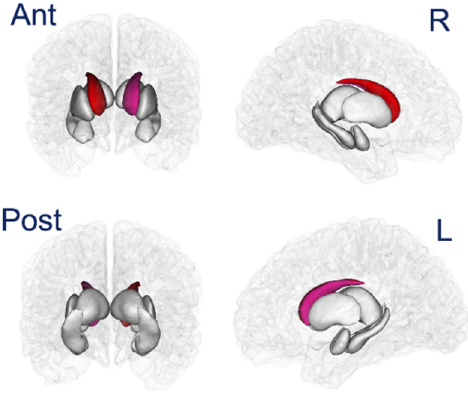
Figure 5. Visualization of the statistical significance of surface area measurements in cortical regions (left). On the right, the inflated surface. Non-significant regions are in white, significant regions (following correction for multiple comparison) are shown in blue ( p < 0.05) to red ( p < 0.001).